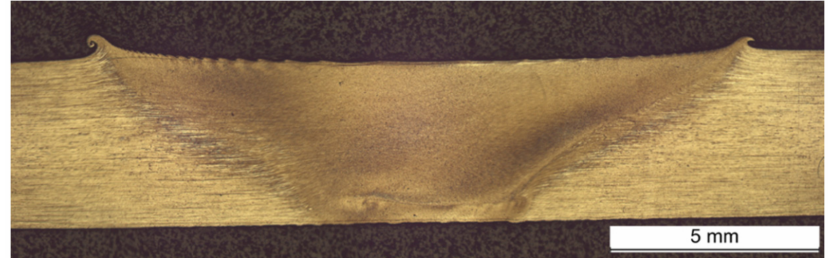
Figure 22. Cross section tool 1-15-0 with 0.9 mm